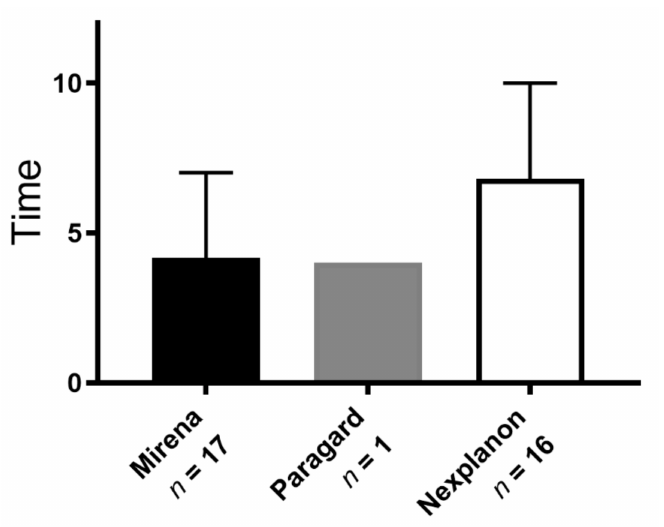
Figure 3. Thirty-four (11%) women chose early removal of their LARC. Mean time (in months) from insertion to removal varied significantly by device type. Error bars represent